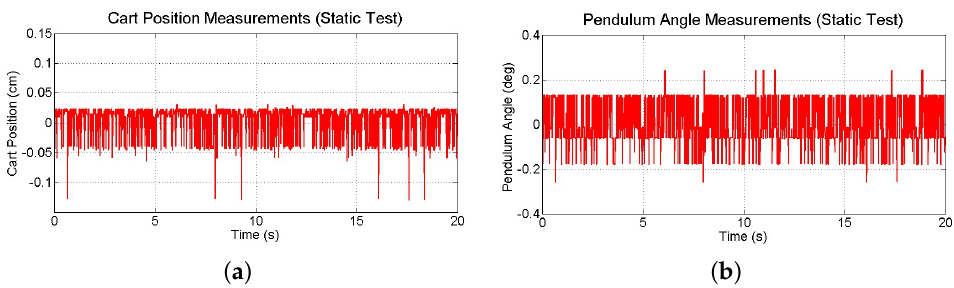
Figure 13. Measurements of ( a ) cart position and ( b ) pendulum angle collected during a static test.